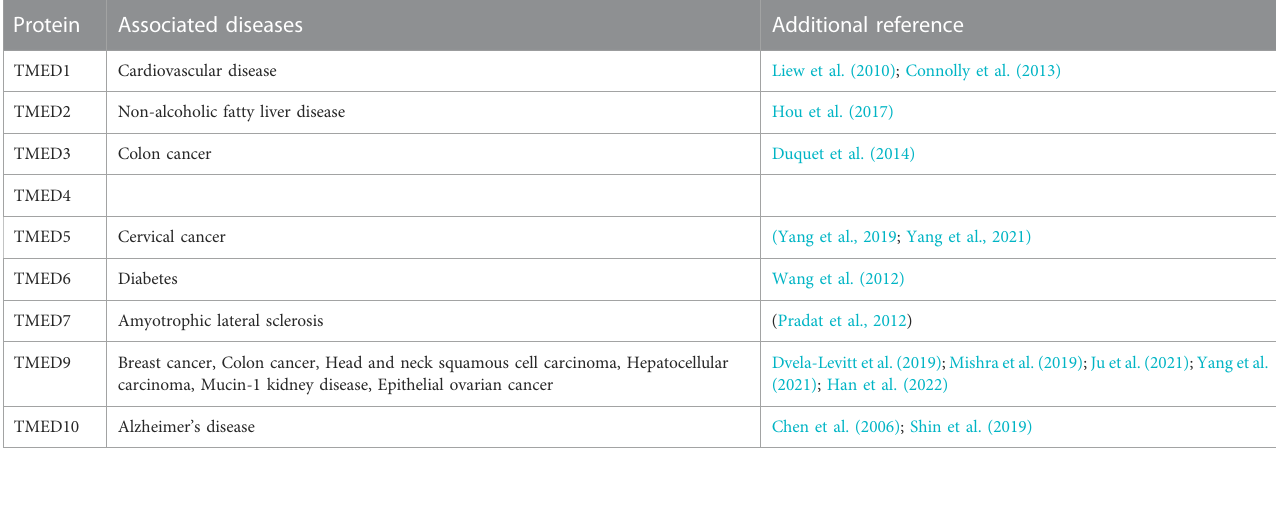
TABLE 1 Diseases associated with individual TMED family